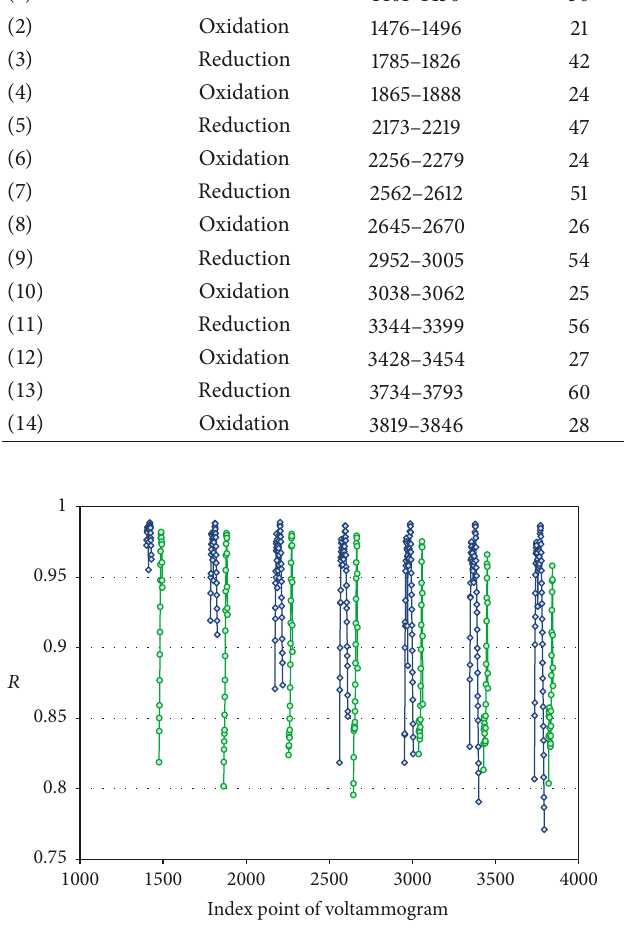
Figure 3: SIMCA modeling power (𝑅) (𝐹 = 1) calculated indi- vidually and independently from other ranges for each of 𝐾 ranges (Table 2). Ranges corresponding to reduction and oxidation signals are denoted with blue diamonds and green circles,